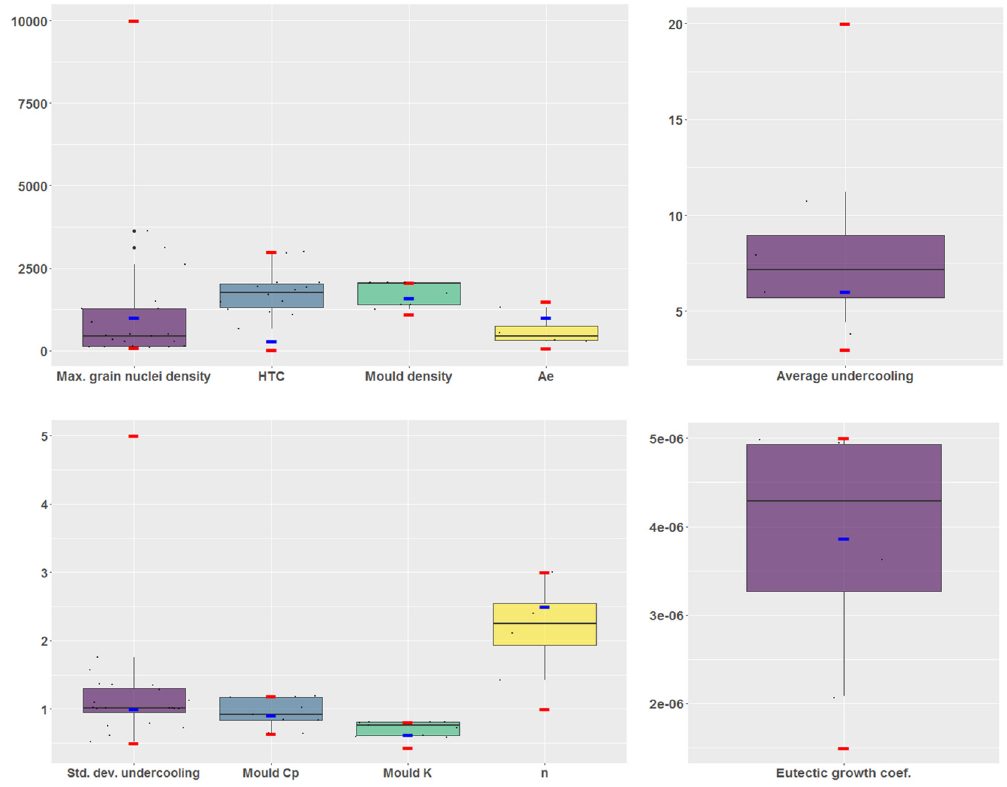
Figure 9. Distribution of the values assigned to the different variables in boxplot form.